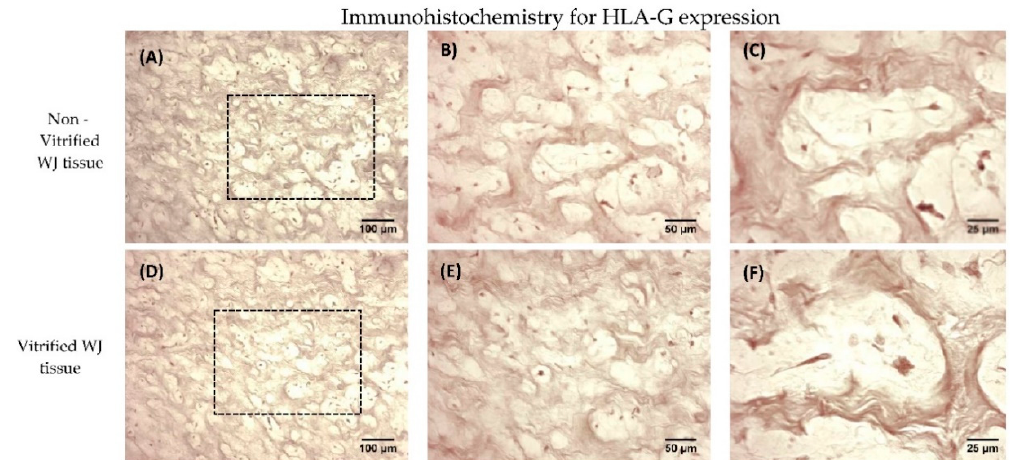
Figure 4. HLA-G expression in WJ tissue. Immunohistochemistry results regarding the HLA-G expression in non-vitrified (n = 5) WJ tissue ( A – C ). Immunohistochemistry results regarding the HLA-G expression in vitrified (n = 5) WJ tissue ( D – F ). The black boxes in 10× images ( A , D ) highlights the region that was magnified in images B , C , E , F . Images A , B were acquired with original magnification 10×, scale bars 100 μ m. Images B , E were acquired with original magnification 20×, scale bars 50 μ m. Images C , F were acquired with original magnification 40×, scale bars 25 μ m.